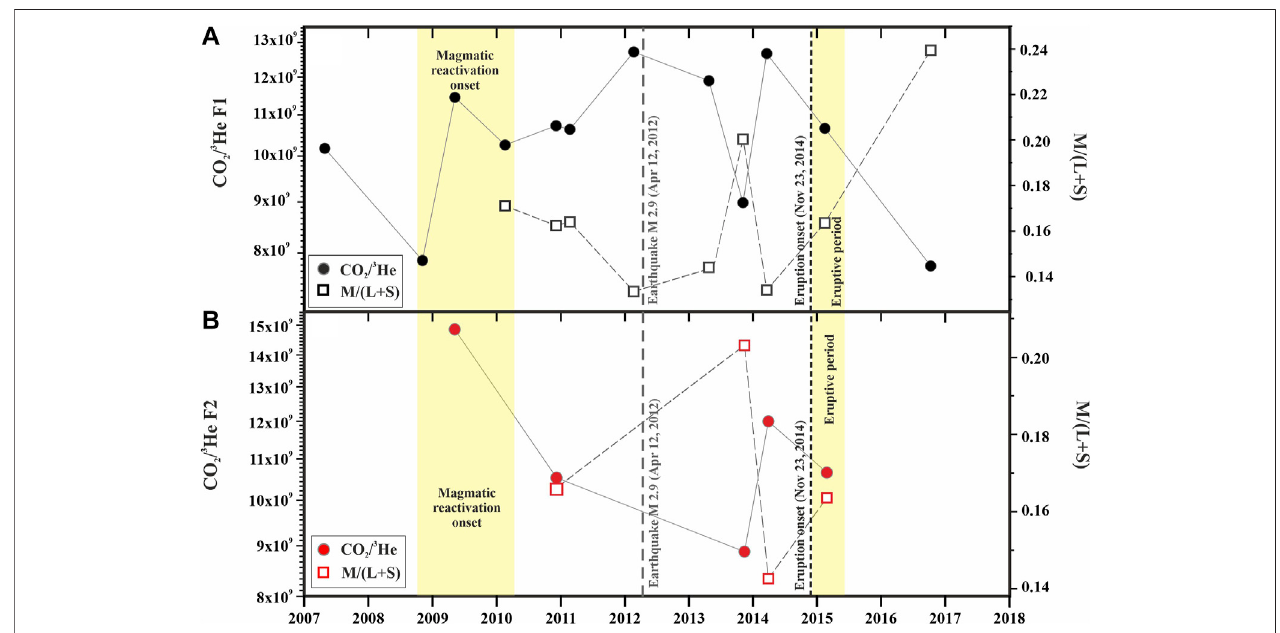
FIGURE 12 | Temporal evolution of CO 2 / 3 He and M/(L + S) ratio (L (cid:2) limestone, S (cid:2) organic sediment and M (cid:2) mantle sources) for F1 (A) and F2 (B) fumarole emissions.